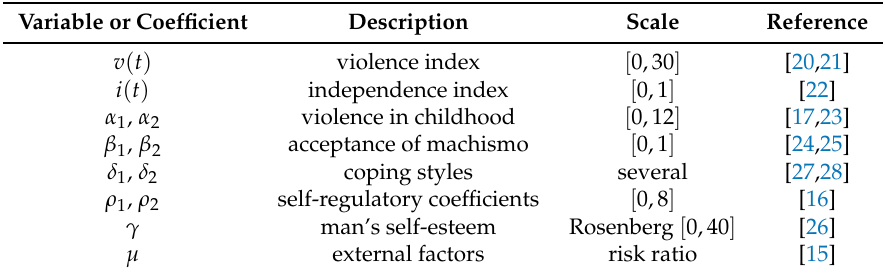
Table 1. Informational table of the variables and parameters of the